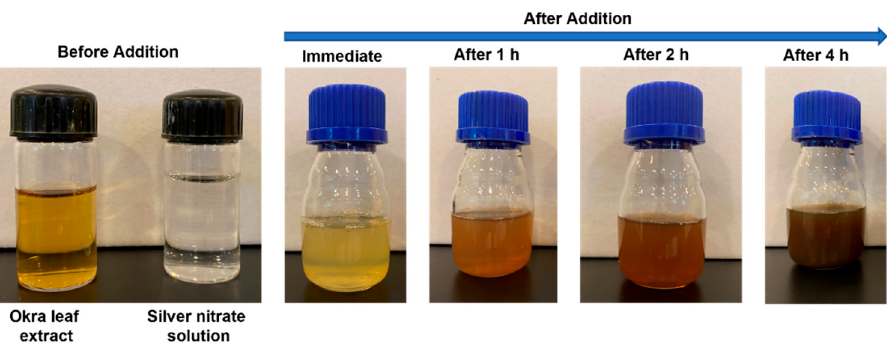
Figure 1. Digital image showing the formation of silver nanoparticles as indicated by color change.